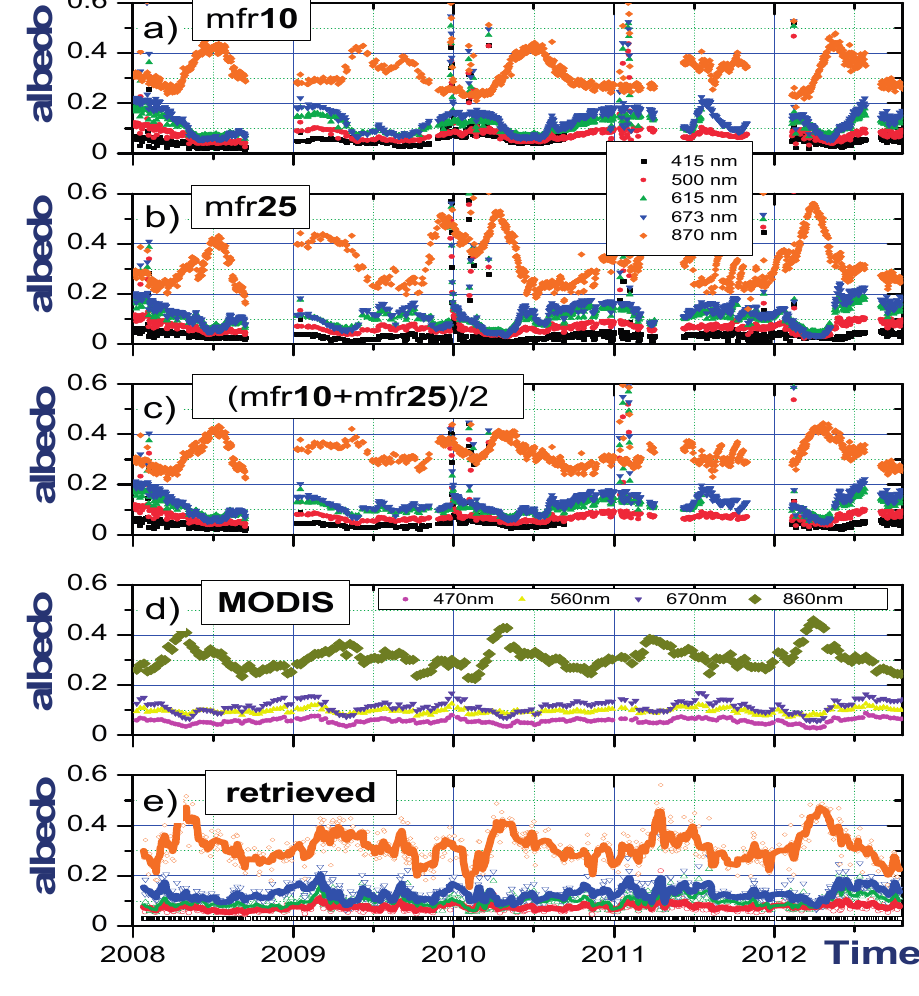
Figure A1. Time series of the tower-measured 10-m ( a ) and 25-m ( b ) surface albedo at the ARM site, their weighted average ( c ); MODIS-derived ( d ) and MFRSR-retrieved areal-averaged surface albedo ( e ). Black, red, green, blue and orange colors define the surface albedo values (a–c,e) at five MFR/MFRSR wavelengths (415, 500, 615, 673 and 870 nm). Magenta, yellow, violet and dark yellow colors define the surface albedo values (d) at four MODIS wavelengths (470, 560, 670 and 860 nm); (e) Solid lines (red, green, blue and orange) represent the smoothed versions of MFRSR-retrieved surface albedos at four wavelengths (500, 615, 673 and 870 nm) (boxcar averaging; 5